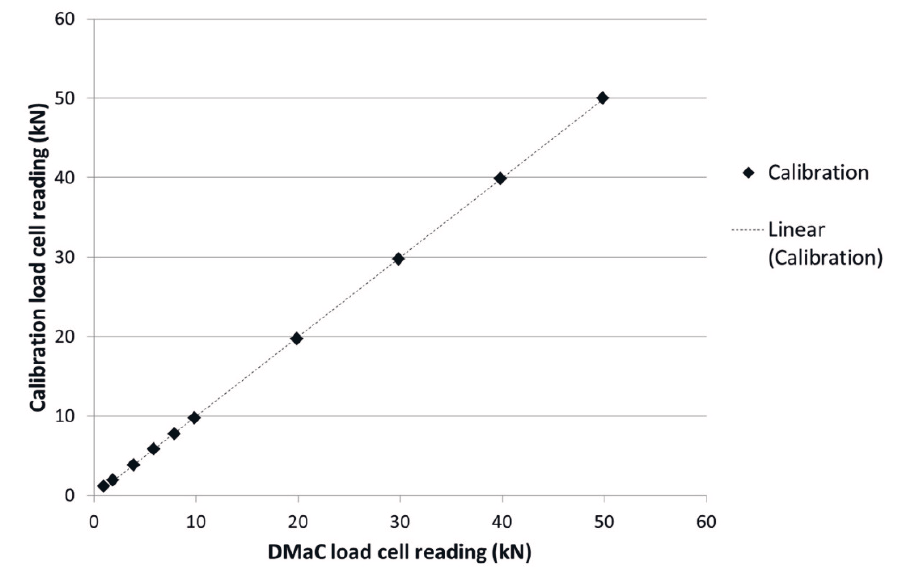
Figure 5. Final calibration run of DMaC using 5 T reference load